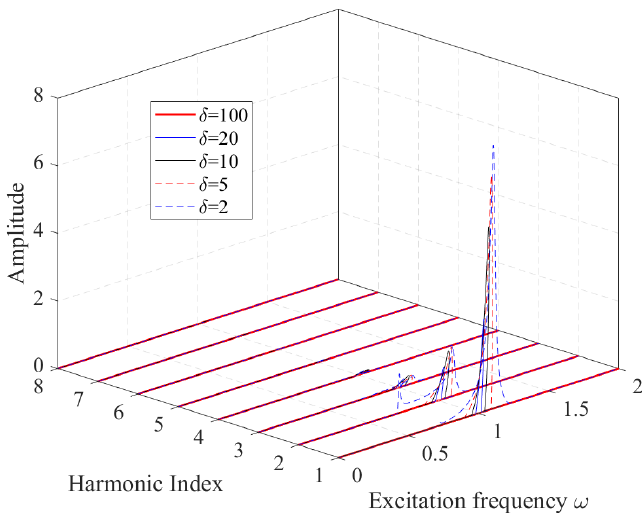
Figure 6. Amplitudes of super-harmonic terms of Dof-2 (absolute value).